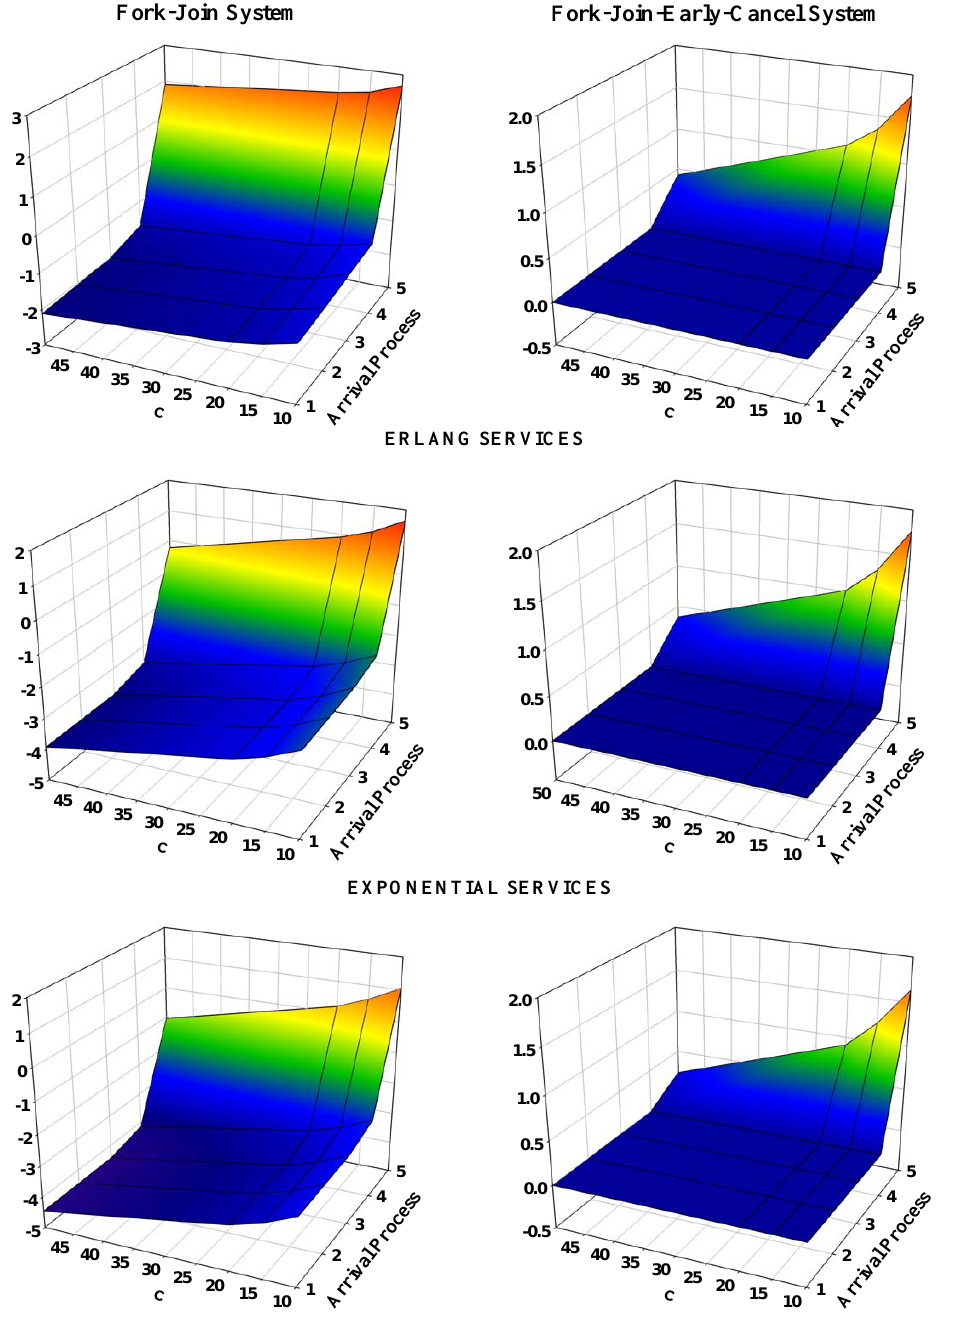
Figure 6: Plot of E ( L ) under various scenarios